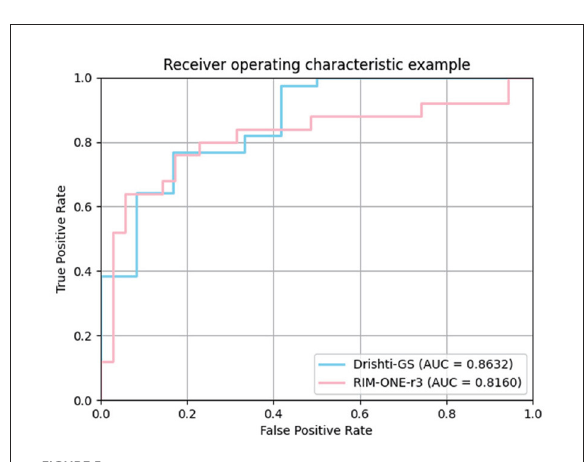
FIGURE5 ROC curves of our method for glaucoma screening on Drishti-GS and RIM-ONE-r3